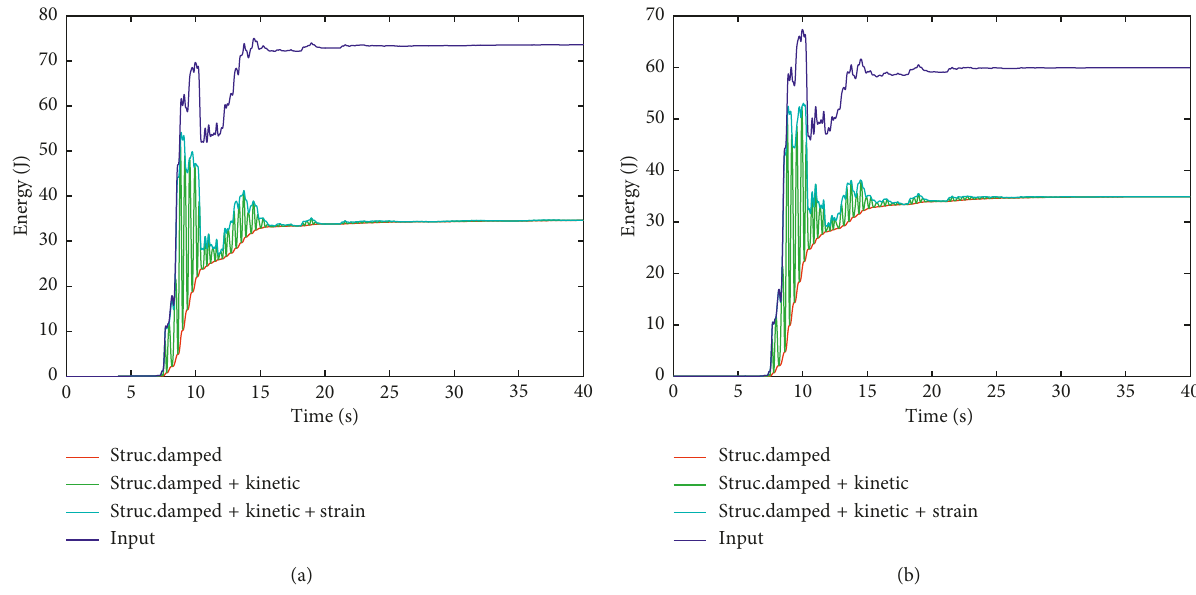
Figure 9: Input and dissipated energy of the controlled structure under Kobe earthquake with a (a) PTRMD and (b) PMD.